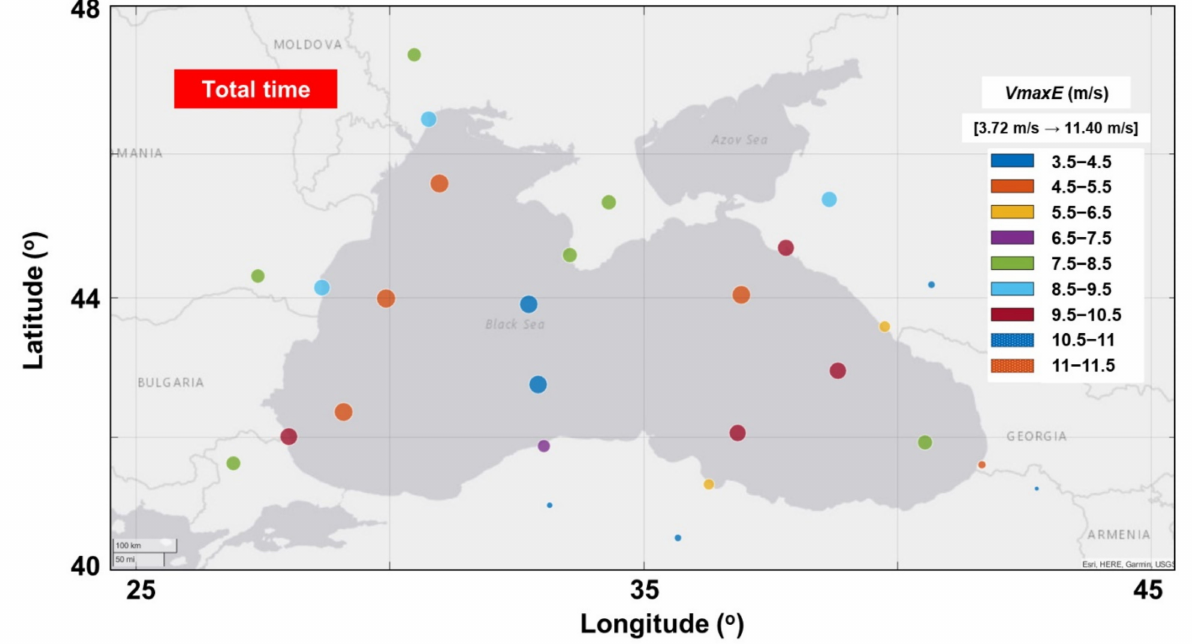
Figure 7. Overview of the V maxE indicator (in m/s) associated with each reference point. Results computed for the entire 20-year time interval (2002–2021) and related to the U 100 parameter. The numbers from the square brackets indicate the minimum and maximum values related to this